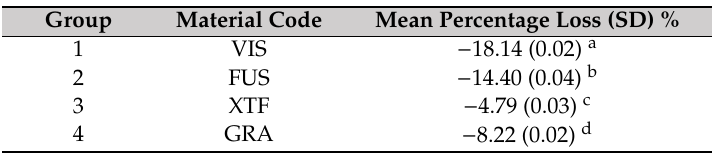
Table 3. Mean percentage micro-hardness loss of the internal side of each tested material, compared to the external side.